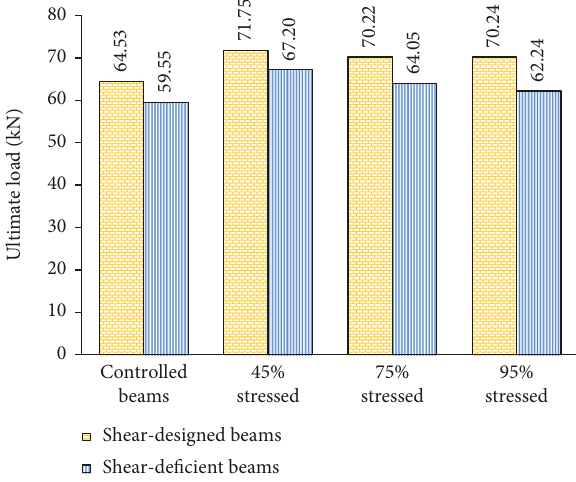
Figure 11: Comparison of ultimate loads of shear-designed and shear-deficient beams tested at a / d 3.